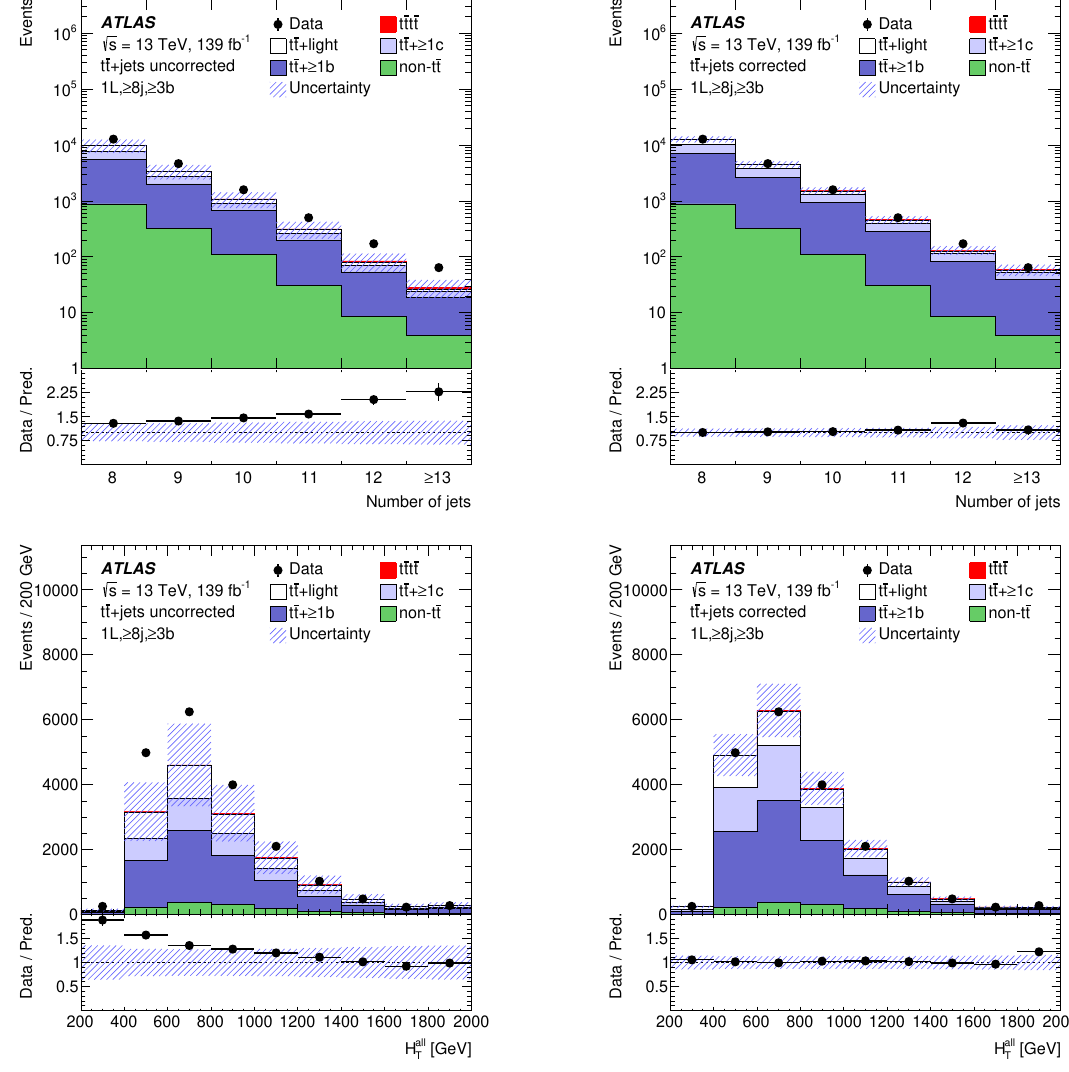
Figure 4 . The N and H all distributions in the region with ≥ 8 jets and ≥ 3 b -jets in the 1L chan- jets T nel before (left) and after (right) the flavour rescaling and the sequential kinematic reweighting. The band includes the total pre-fit uncertainty of the MC prediction. The ratio of the data to the total MC expectation is shown in the lower panel. The last bin in all distributions includes the